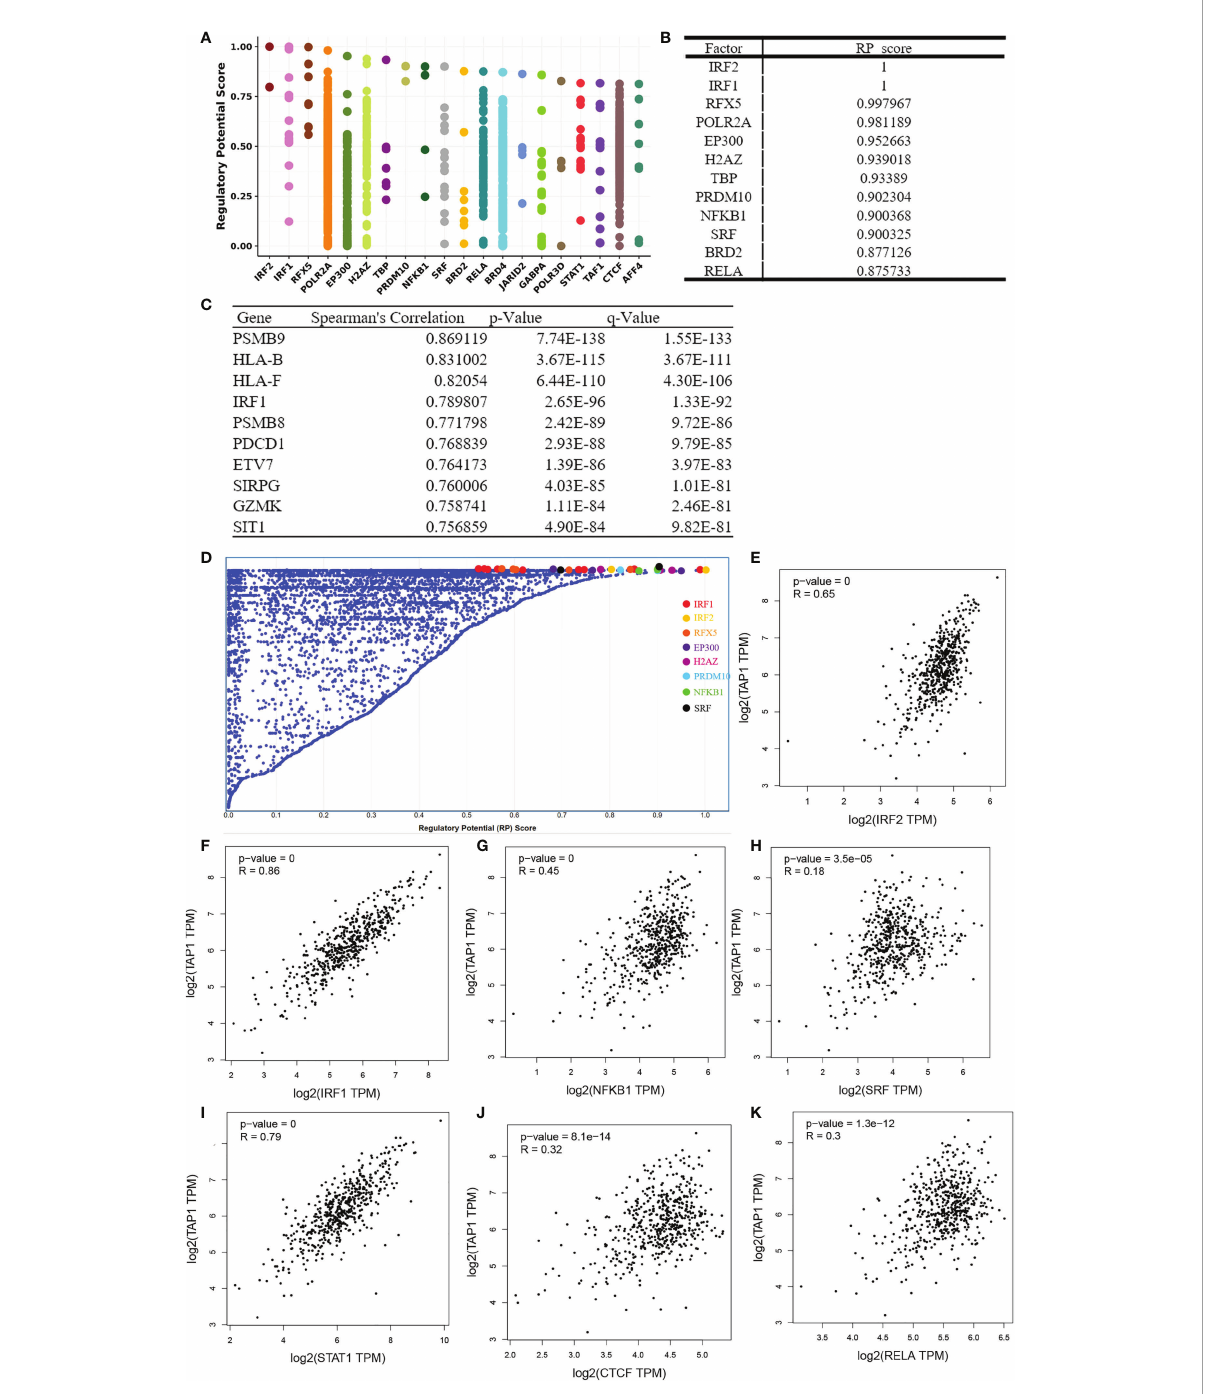
FIGURE 6 Identi fi cation of TAP1-related Transcription factors(TFs). (A, D) TAP1 was regulated by those 20 most likely TFs in human cancers. (B) Top 12 transcription factors based on Regulatory Potential (RP) Scores. (C) Top 10 genes correlated with TAP1 obtained from cBioportal database. (E-K) There ’ s a connection between TAP1 mRNA expression and these transcriptional factors, such as IRF2 (cor. = 0.65), IRF1 (cor. = 0.86), NFKB1 (cor. = 0.45), SRF (cor. = 0.18), STAT1 (cor. = 0.79), CTCF (cor. = 0.32), and RELA (cor. = 0.3) in KIRC based on Gene Expression Pro fi ling Interactive Analysis (GEPIA)